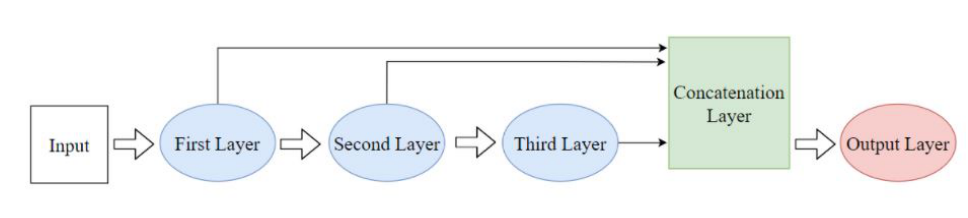
Figure 3. Illustration of skip connections neural network